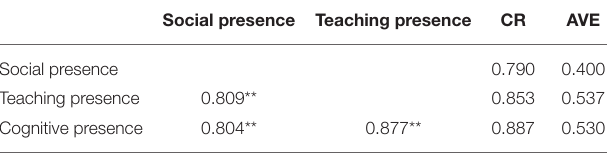
TABLE 3 | The convergent validity and correlation analysis of the measurement items.